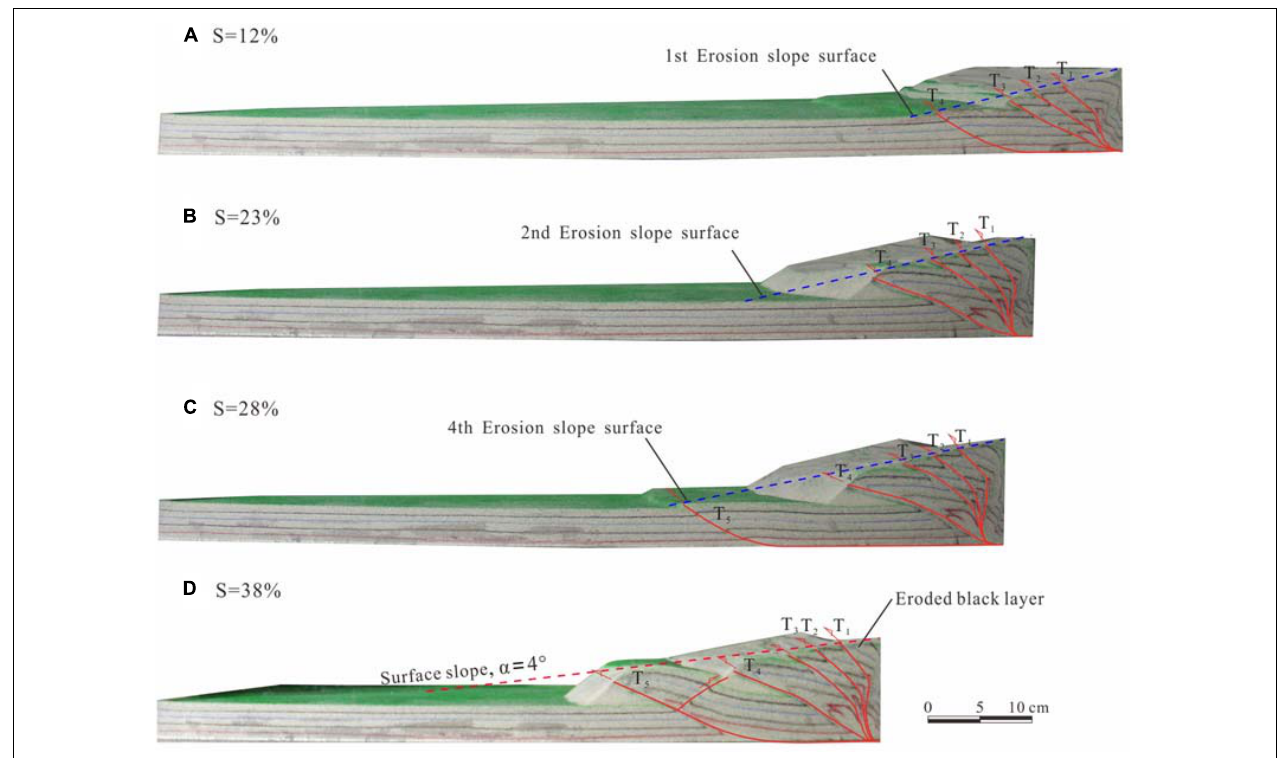
FIGURE 4 | Experiment results of low rate of erosion model (E3). (A–D) Sequential photographs showing the structural evolution of